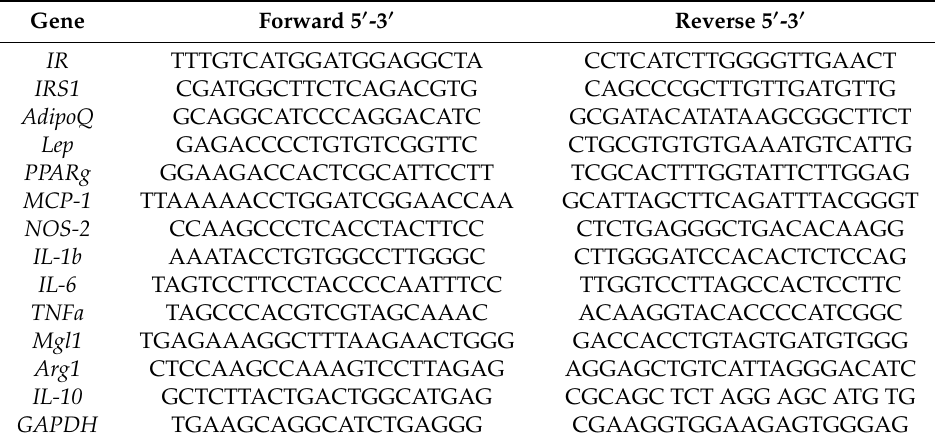
Table 1. qPCR Primer